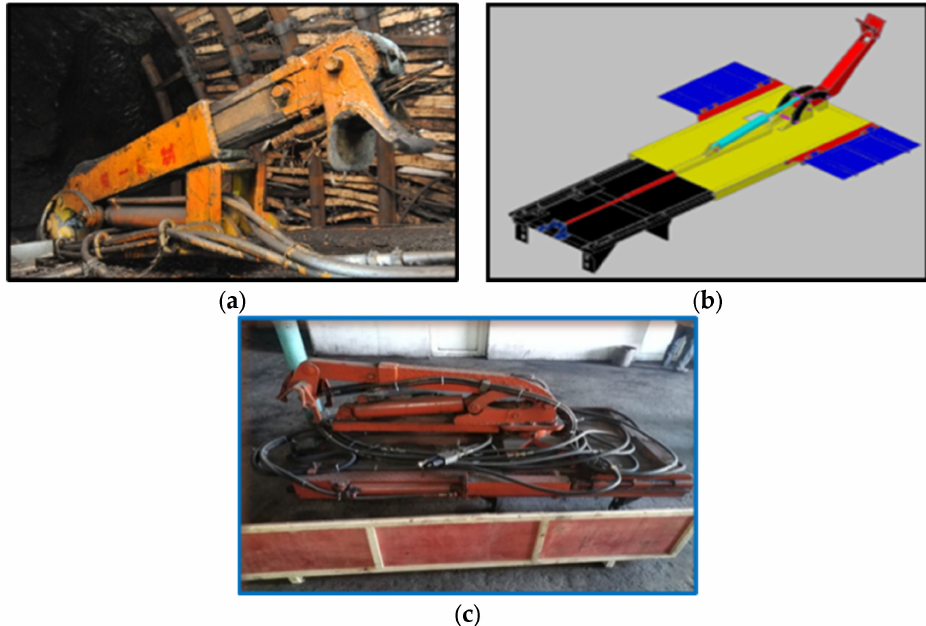
Figure 15. Combined onboard standing platform + onboard beam lift device. ( a ) 1st generation. ( b ) 2nd generation. ( c ) 3rd